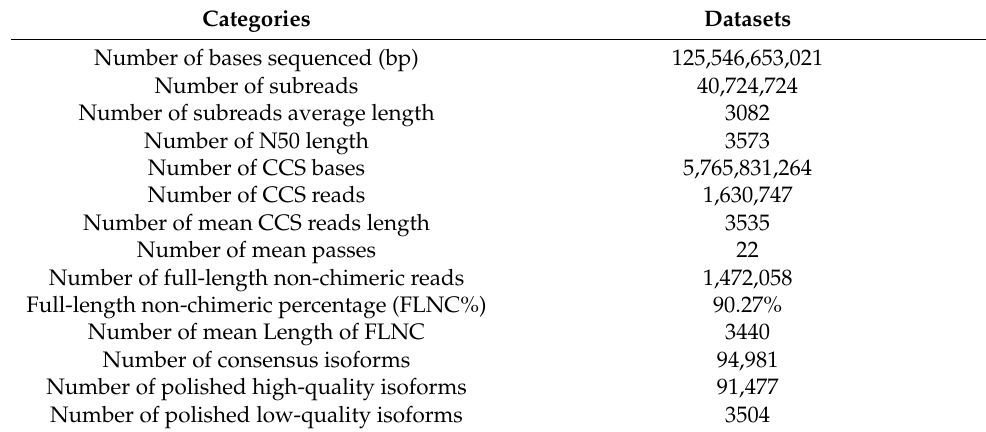
Figure 2. Length distributions of PacBio SMRT sequencing. ( A ) Number and length distributions of 1,630,747 CCS sequences. ( B ) Number and length distributions of 1,472,058 FLNC sequences. ( C )